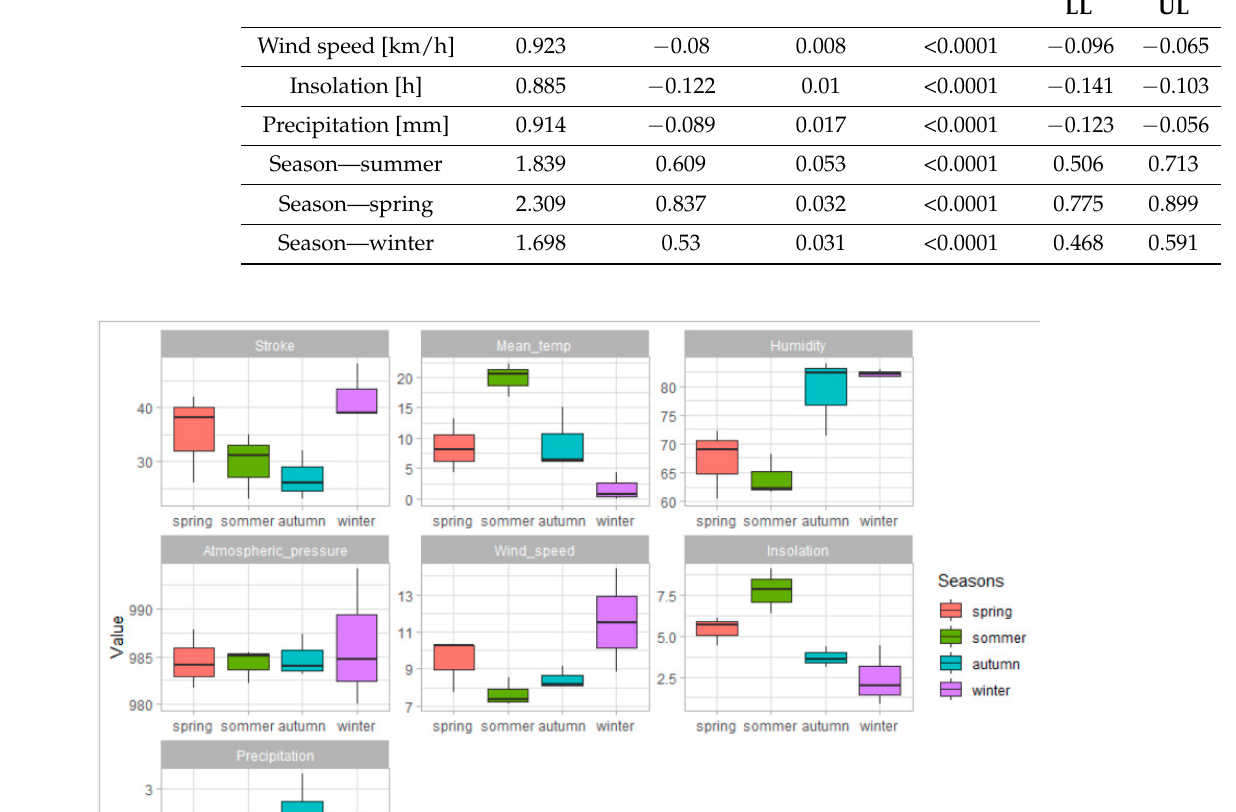
Table 6. Types of stroke in each moon phase.